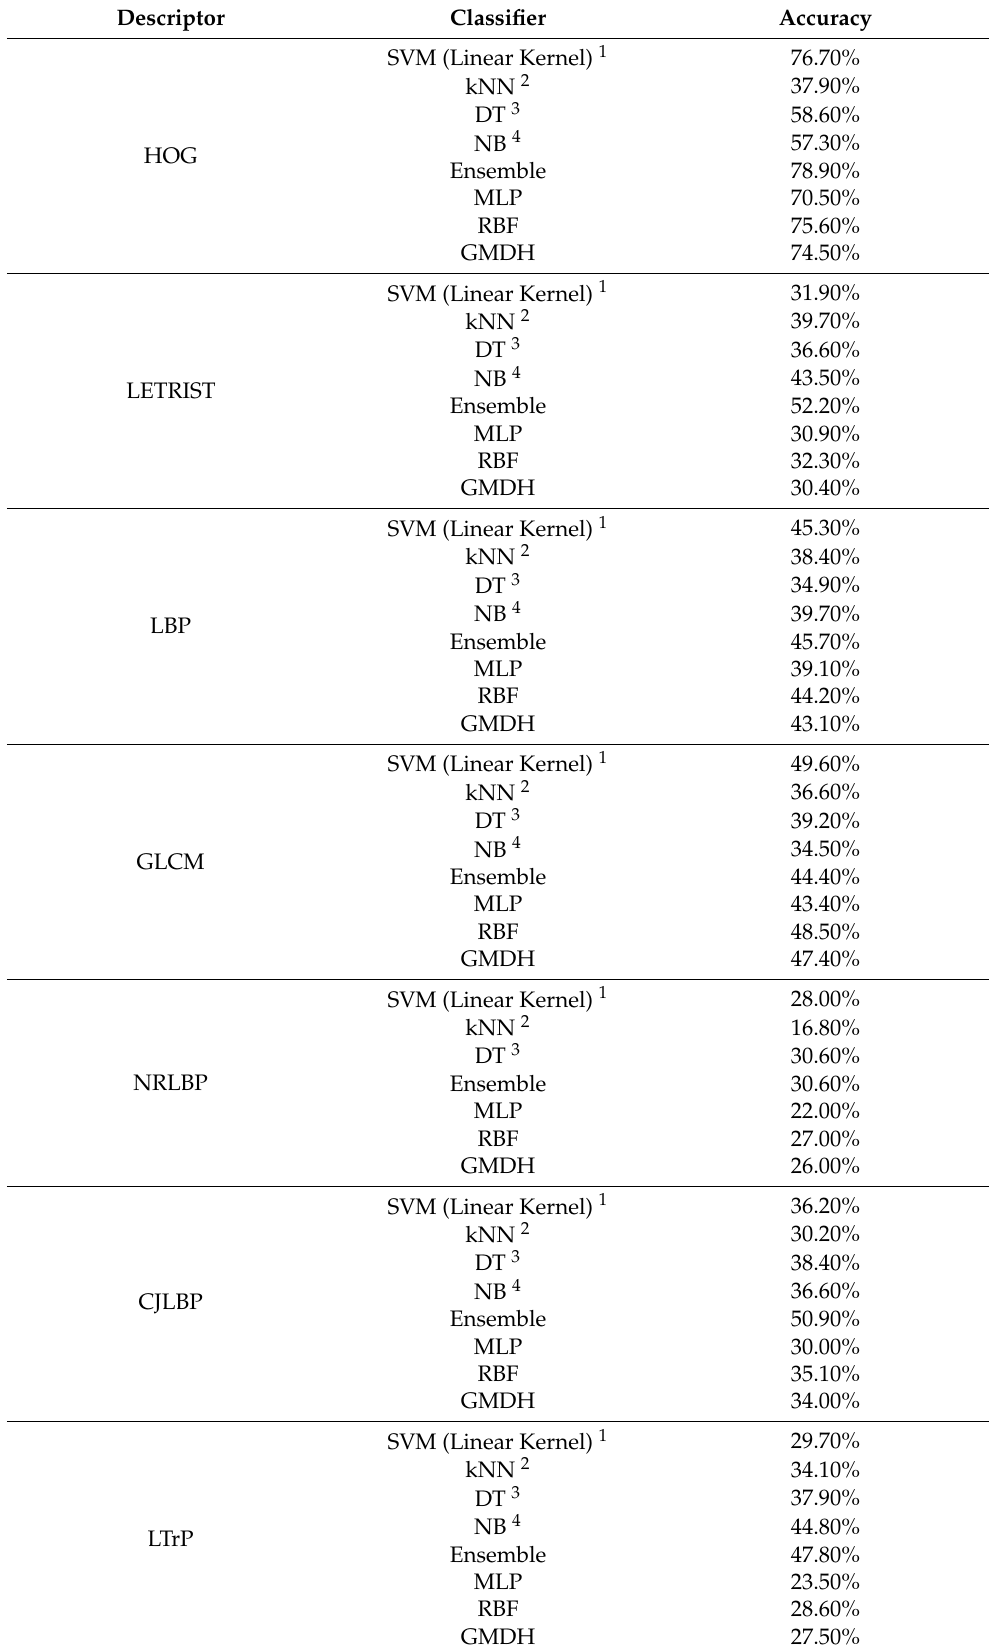
Table 2. Performance comparison of various handcrafted descriptors considering different